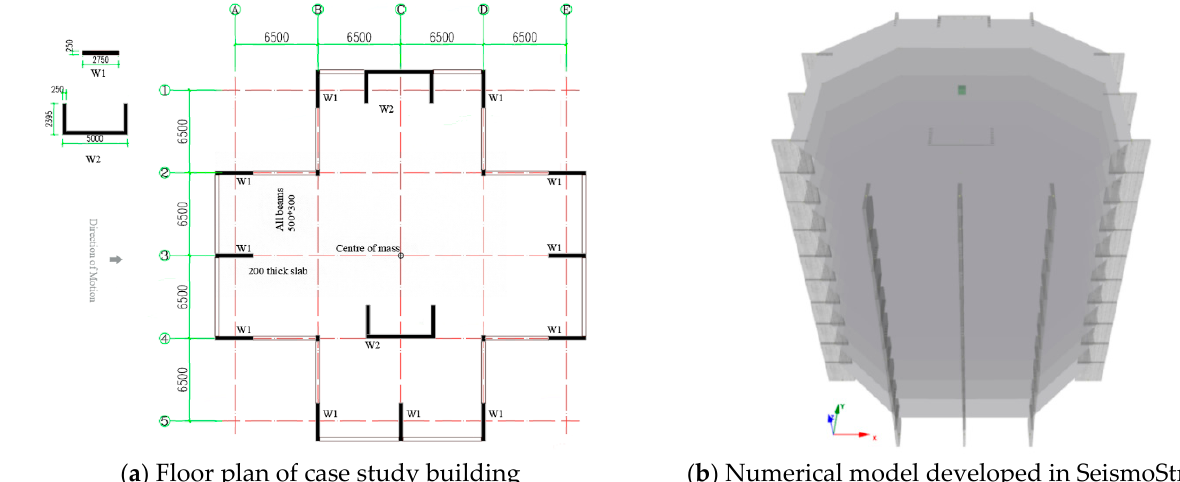
Figure 6. Floor plan of case study building and numerical models.